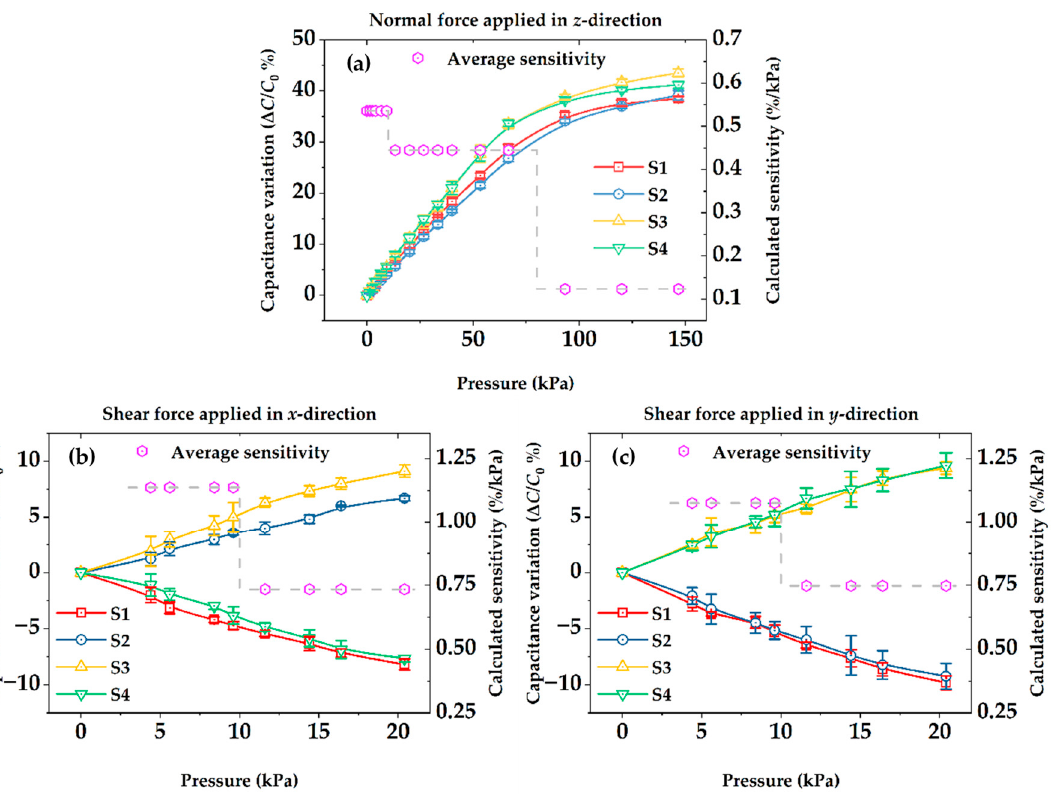
Figure 6. Illustration of the pressure-sensing properties of a unit sensing element to external forces: ( a ) Normal force applied in z direction; ( b ) Shear force applied in x direction; ( c ) Shear force applied in y direction.